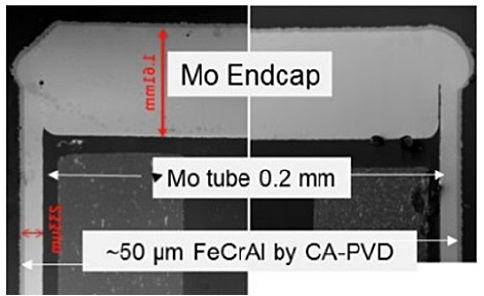
Fig. 5. Uniform FeCrAl coating thickness of 50 m m on a welded Mo tube (similar results for Zircaloy coating).